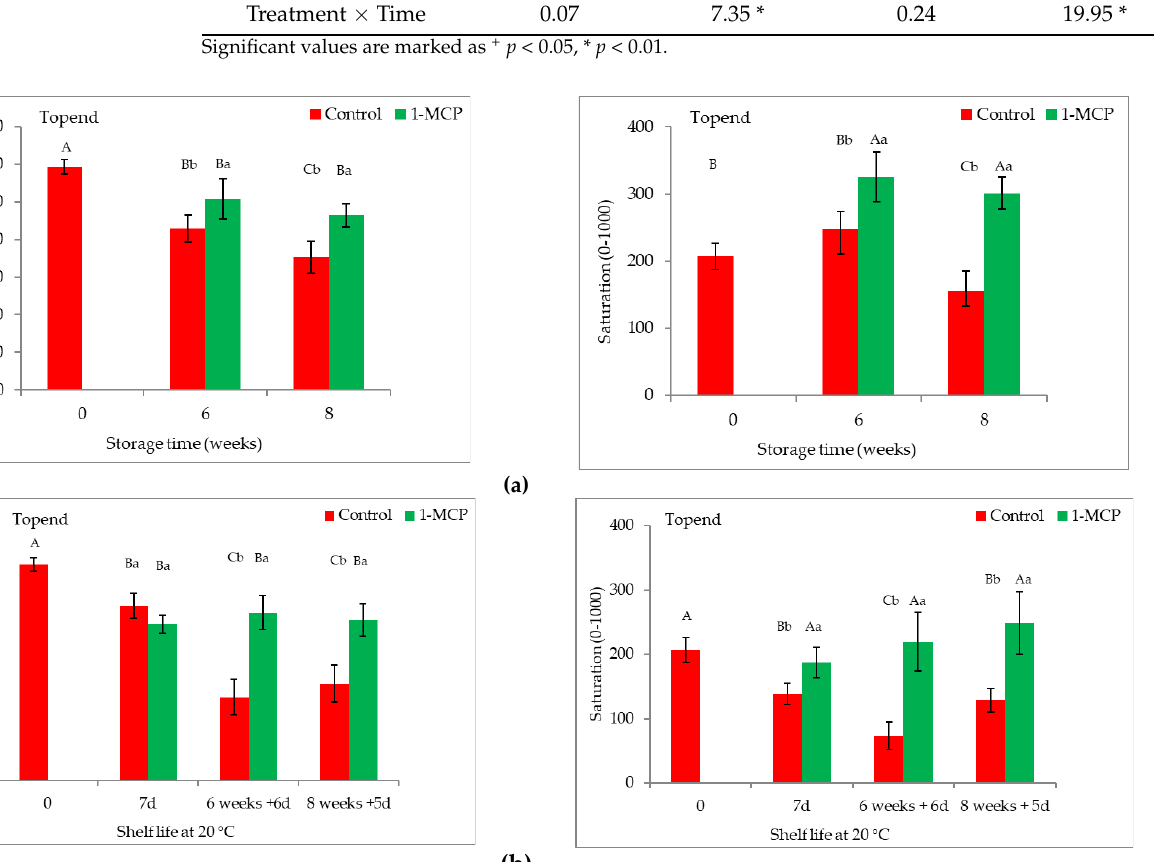
Figure 7. Hue angle ( left ) and saturation ( right ) of flesh of ‘Topend’ samples during cold storage at 1 °C ( a ) and subsequent shelf-life storage at 20 °C ( b ). Upper case is for the comparisons of time (Tukey’s, p < 0.05). Lower case is for the comparisons of treatment (Tukey’s, p < 0.05).